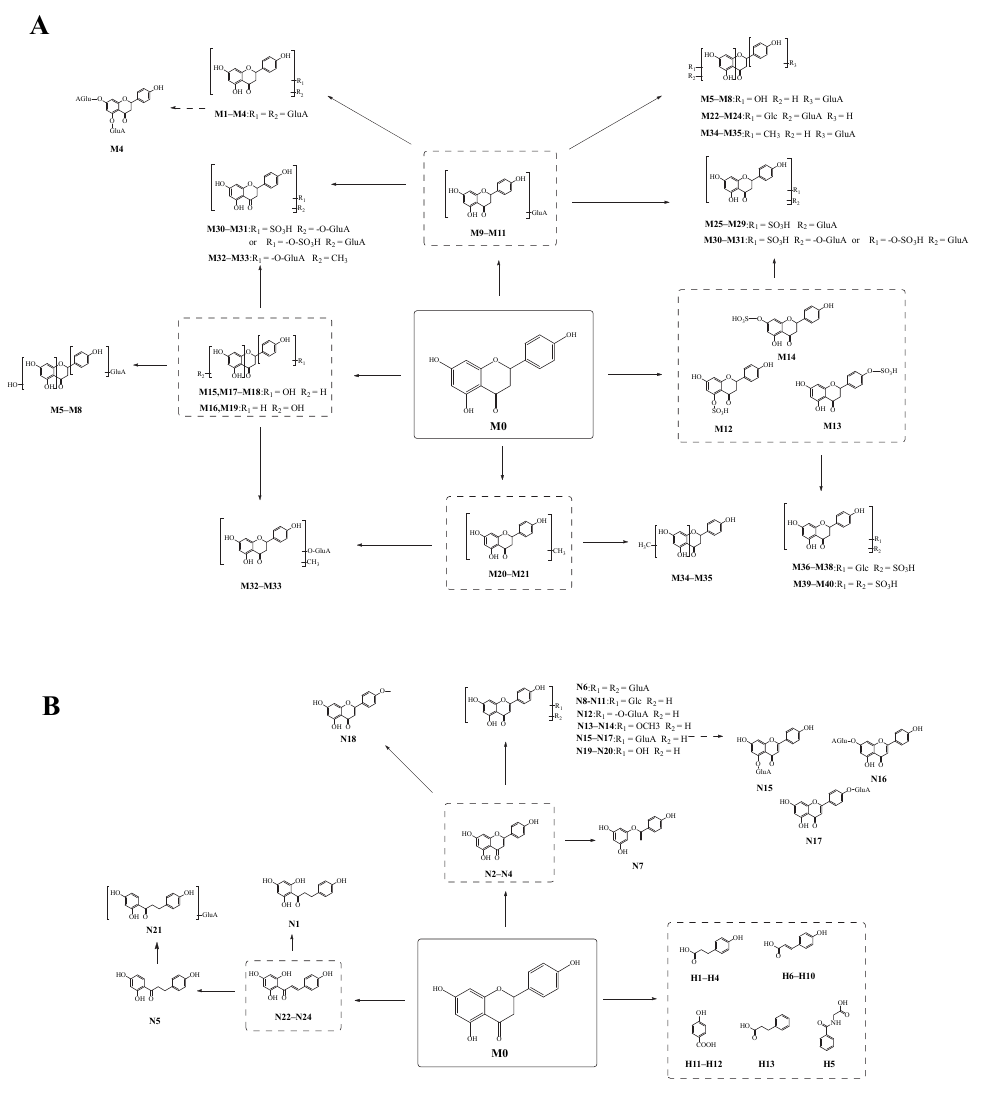
Figure 5. The possible metabolic pathways of naringenin. ( A ): the possible metabolic pathway of naringenin by “reaction I”; ( B ): the possible metabolic pathway of naringenin by “reaction II”.